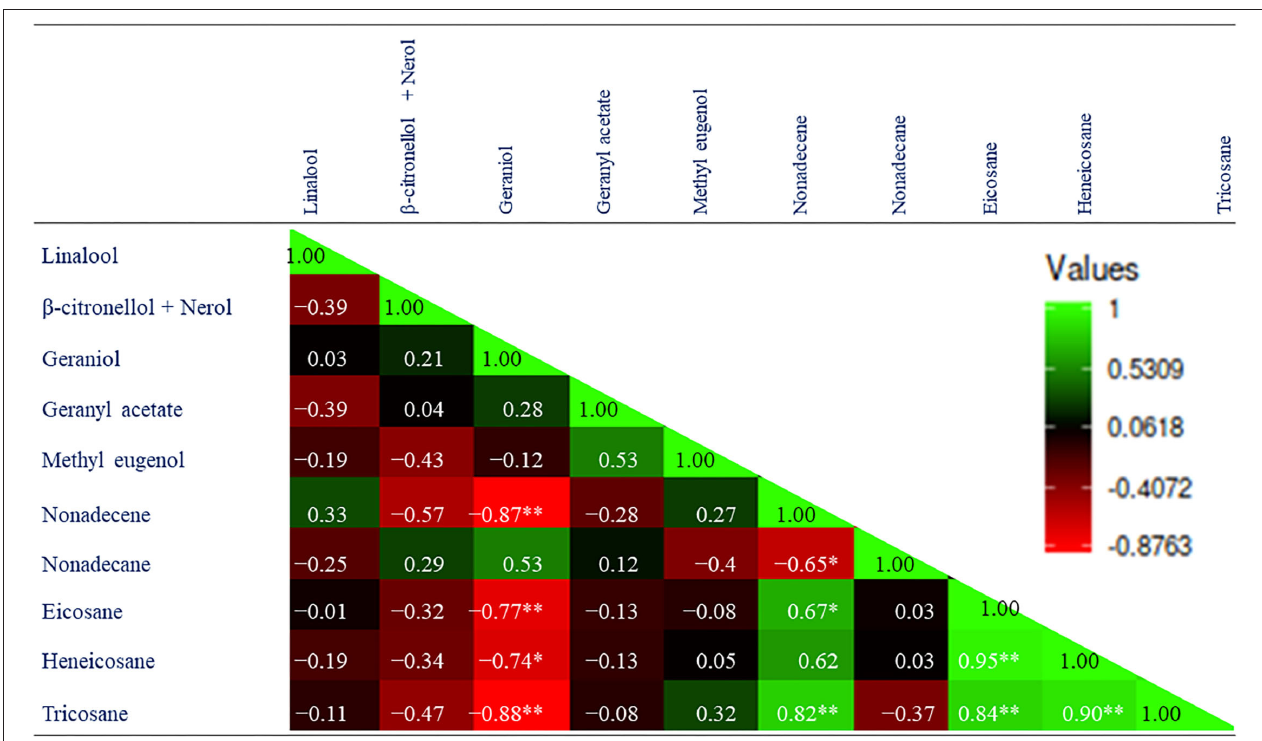
FIGURE 3 | Correlation matrix among the major components of essential oil of R. damascena . The mean values of the 2-year pooled data of the corresponding treatments are used (where N1 = N2 = 10).